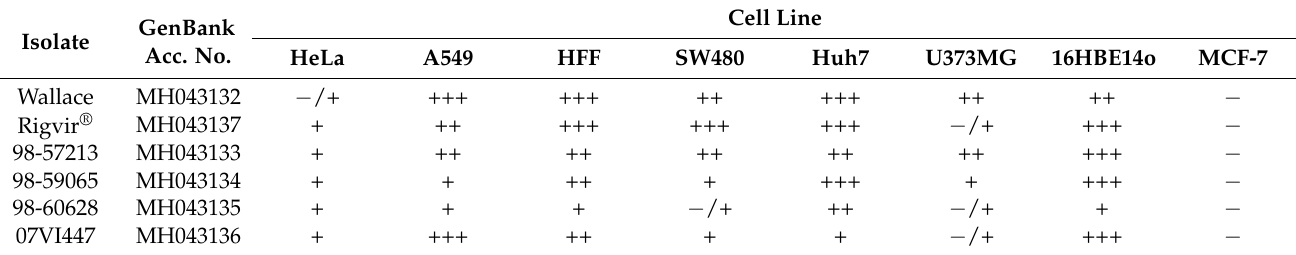
Table 2. Cytopathogenicity (CPE) results 3 days post-infection using TCID50. Results are marked as CPE using terminology with ( − ; no cytolysis), ( − /+, borderline result), (+; few cells lysed), (++; 50% of cells lysed) and (+++; full cytolysis of cells).